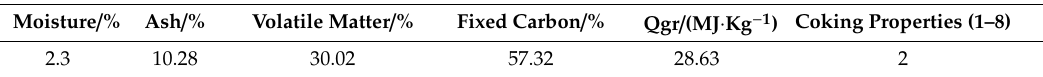
Table 2. Property of the Coal